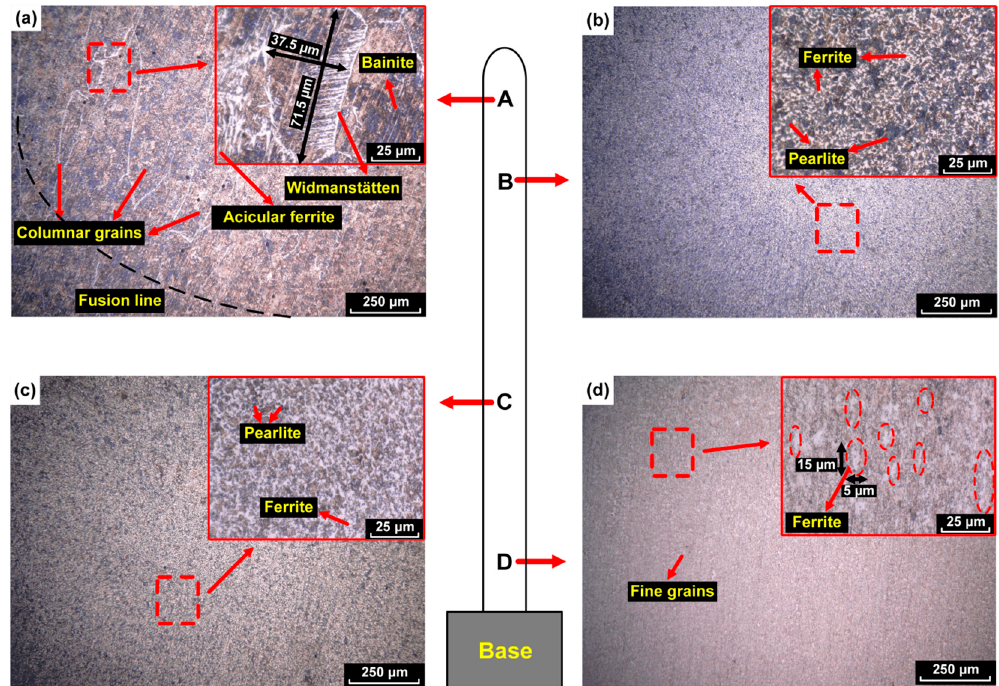
Figure 6. Microstructure of XC-45 single bead wall at different locations, ( a ) region A (close to the wall surface), ( b ) region B (in the middle of the top region), ( c ) region C (middle region), ( d ) region D (bottom region). Metals 2019 , 9 , 673